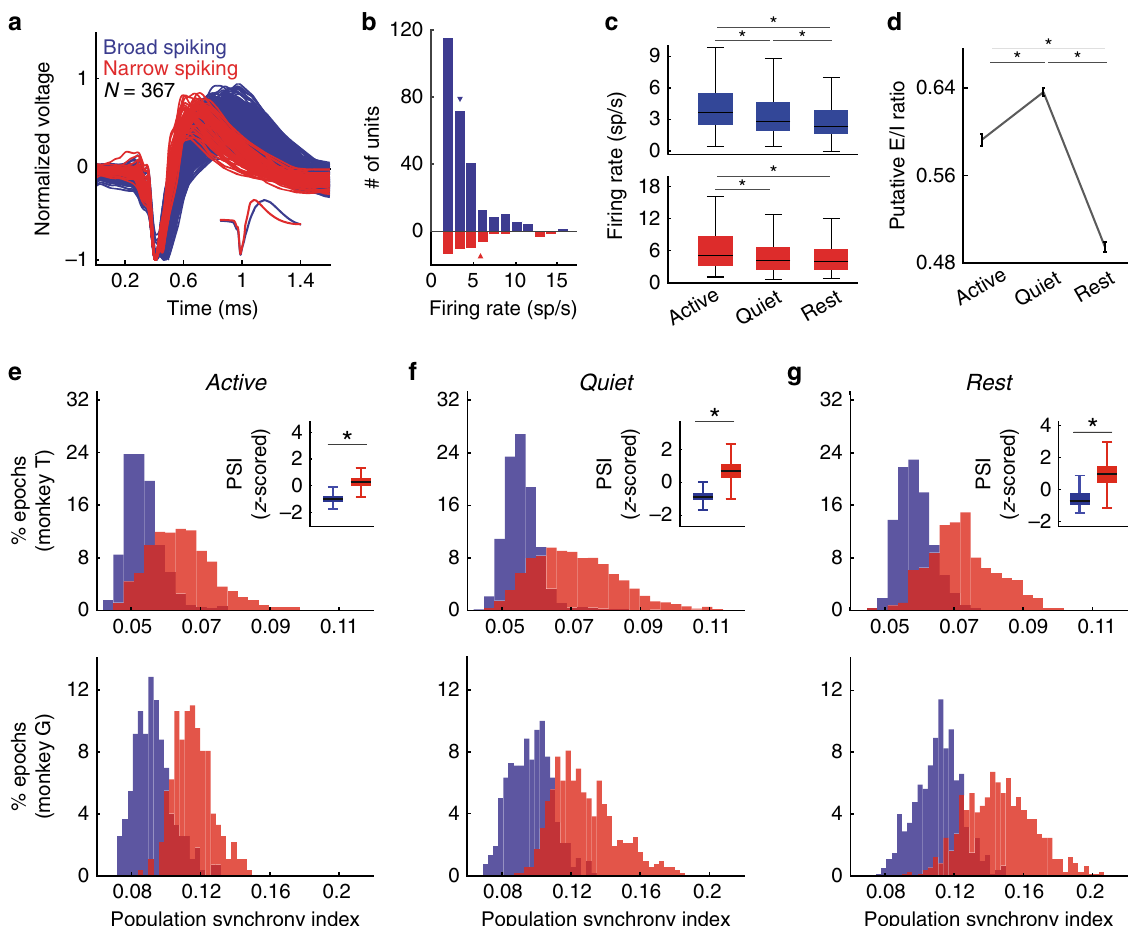
Fig. 4 Putative inhibitory populations are more synchronous than putative excitatory populations. a Mean spike waveforms of 367 recorded single units classi fi ed as narrow-spiking or broad-spiking based on peak-to-trough duration. b Narrow-spiking units had a signi fi cantly higher mean fi ring rate than broad-spiking units (5.63 sp/s vs. 4.02 sp/s; p = 0.0023, two-sided Wilcoxon rank-sum, n = 367 U). c (Top) Mean fi ring rates of broad-spiking units during active, quiet, and rest states. Firing rates are highest in the active state, and lowest in the rest state, and at an intermediate level in the quiet state ( p = 4.1e − 5; Friedman test; asterisks indicate p < 0.0001; two-sided Wilcoxon signed-rank test with Bonferroni correction; n = 308 broad-spiking units). (Bottom) Same analysis for narrow-spiking units. Firing rates are signi fi cantly higher in the active state than either the quiet or rest state ( p = 1.5e − 4; Friedman test; asterisks indicate p < 0.0001; two-sided Wilcoxon signed-rank with Bonferroni correction; n = 59 narrow-spiking units; the reduction in fi ring rates between the quiet and active states is not signi fi cant, p = 0.01). Boxplot box indicates fi rst and third quartile, center line of the box indicates the median, and whisker lengths re fl ect the inter-quartile range multiplied by 1.5. d Putative E / I ratio computed as the ratio of broad-spiking to narrow-spiking fi ring rates across all behavioral states. E / I ratio slightly increases in quiet relative to active state, however there is a particularly strong swing towards inhibition during rest ( p < 0.0001, Kruskal – Wallis test; asterisks indicate p < 0.0001, two-sided Wilcoxon rank-sum test with Bonferroni correction; error bars indicate mean ± standard error, n = 8204 epochs). e – g PSI was computed for both narrow-spiking and broad-spiking populations in active ( e ), quiet ( f ), and rest ( g ) states. Broad-spiking populations for each session were subsampled 100 times to match the population size of the narrow-spiking units and PSI was averaged overall sub-samplings. Broad-spiking PSI and narrow-spiking PSI distributions are shown for both monkey T (top) and monkey G (bottom). PSI for both subpopulations was z -scored and combined across both monkeys for each behavioral state, demonstrating signi fi cantly higher PSI for the narrow-spiking population in all behavioral states (top, insets; asterisks indicate p < 0.0001; two-sided Wilcoxon signed-rank